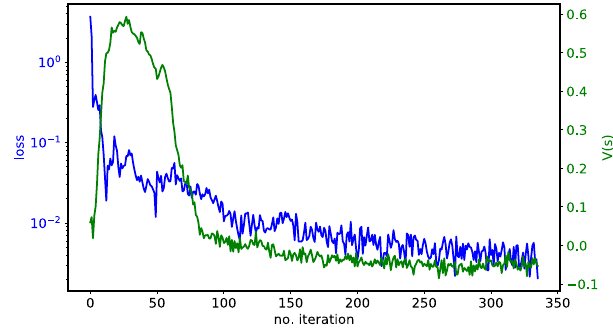
FIG. 7. Evolution of loss and value function during training on November 22, 2019.